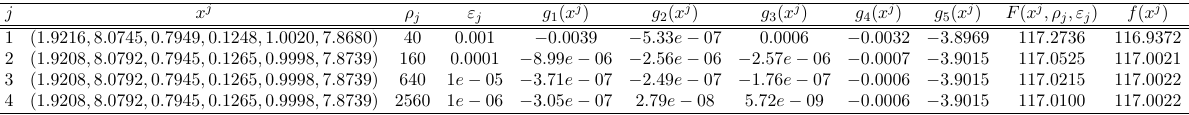
Table 7. Table of minimization process of the Problem